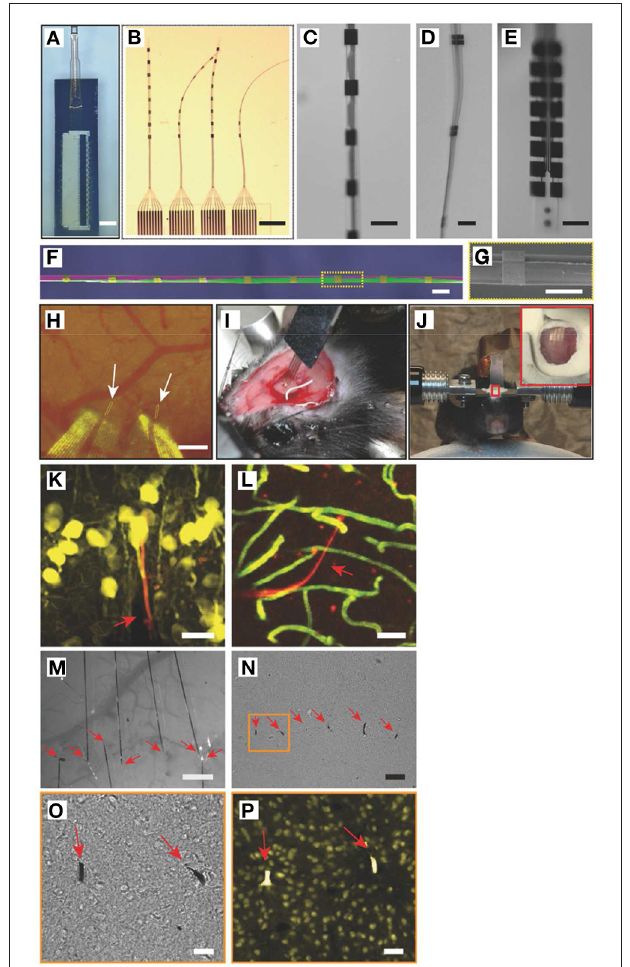
FIGURE 3 | Implantation of flexible neural probes using stiff shuttles to minimize trauma and FBR. Reproduced under the terms of the Creative Commons Attribution License ( Wei et al., 2018). (A–G) Flexible NET-e devices containing multiple electrodes. Hole to connect with the shuttle tool seen at the bottom of (E) . (H–J) Implantation of NET-e devices into the brain using a custom designed and fabricated carbon fiber shuttle device. Entry site indicated by white arrows. (K–P) Tissue response following long-term (2 month: K–L ; 4 month: M–P ) implantation of NET-e devices. No significant neuronal death or vasculature disruption seen. Neuronal staining in yellow (NeuN, K,P ). Vascular staining in green (L) . Devices seen in red fluorescence or pointed by red arrows. Scale bars 50 µ m (K–N) , 10 µ m (O,P)